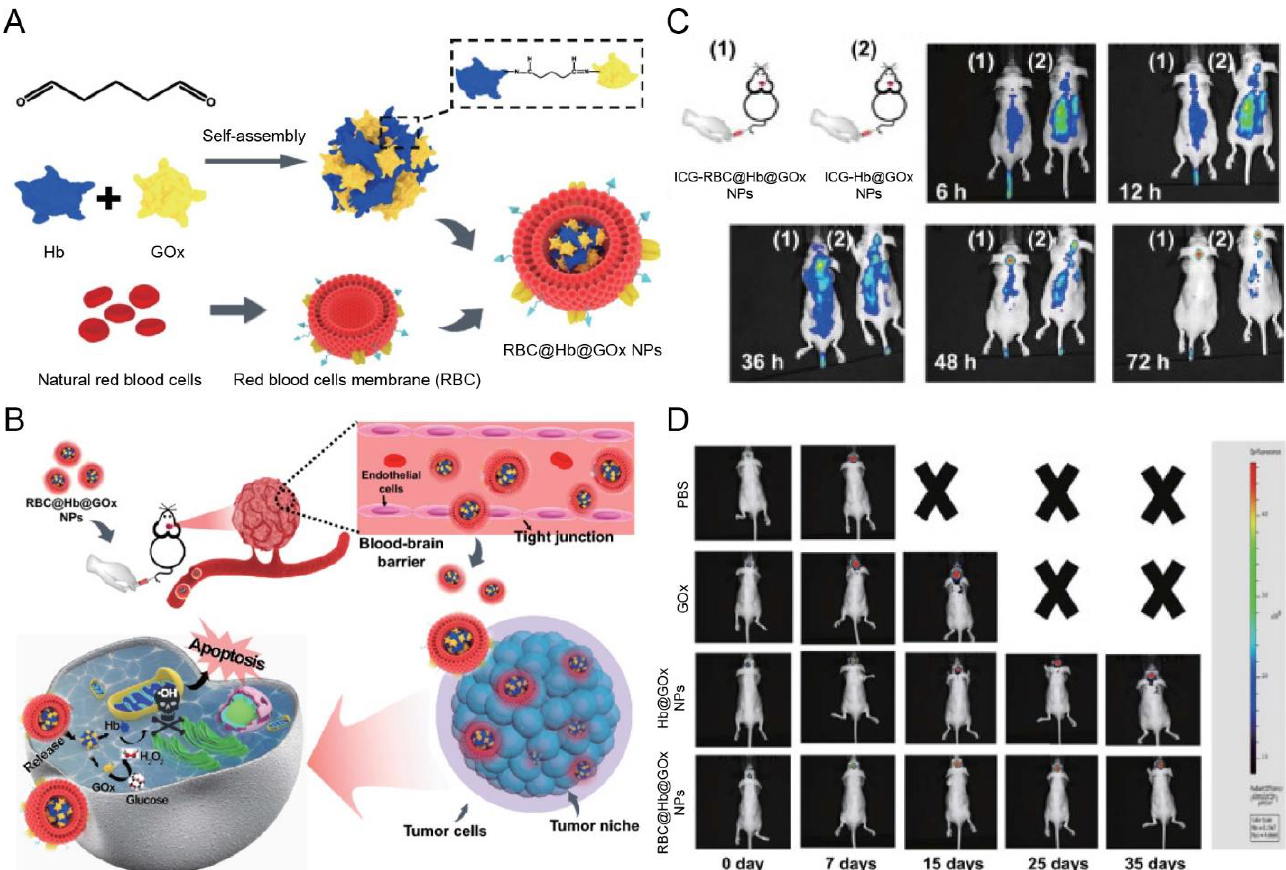
Figure 8. ( A ) Schematic synthesis routes of the RBC@Hb@GOx NPs. ( B ) Scheme of TME-activated